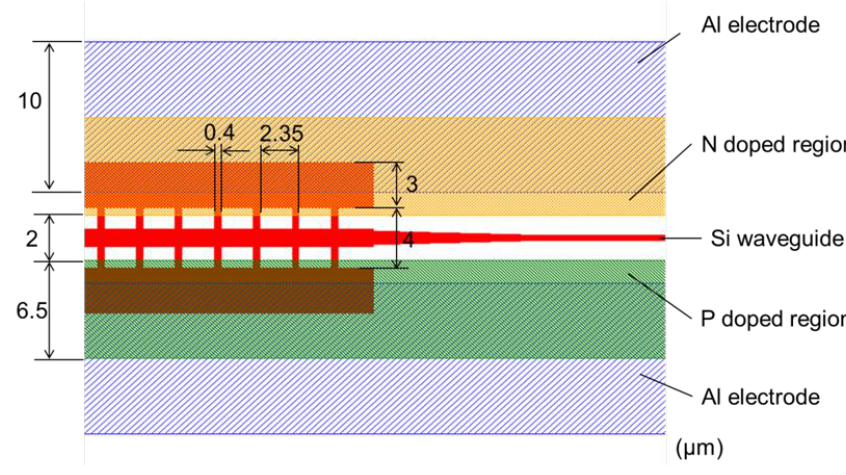
Figure 3. Layout of a phase modulator based on MMI.